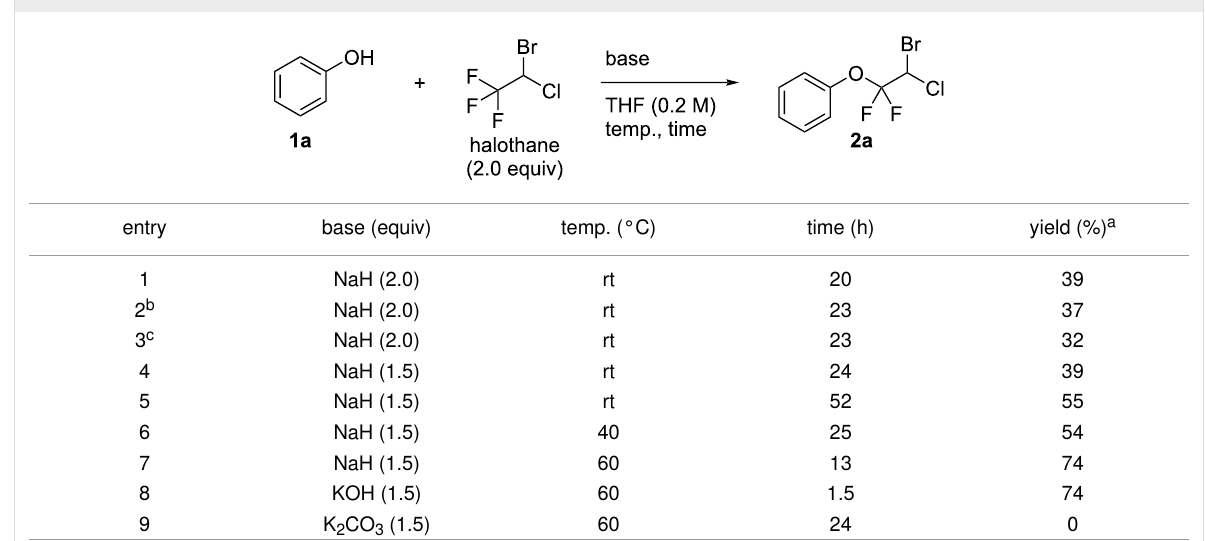
Table 1: Optimization of the reaction conditions with phenol ( 1a